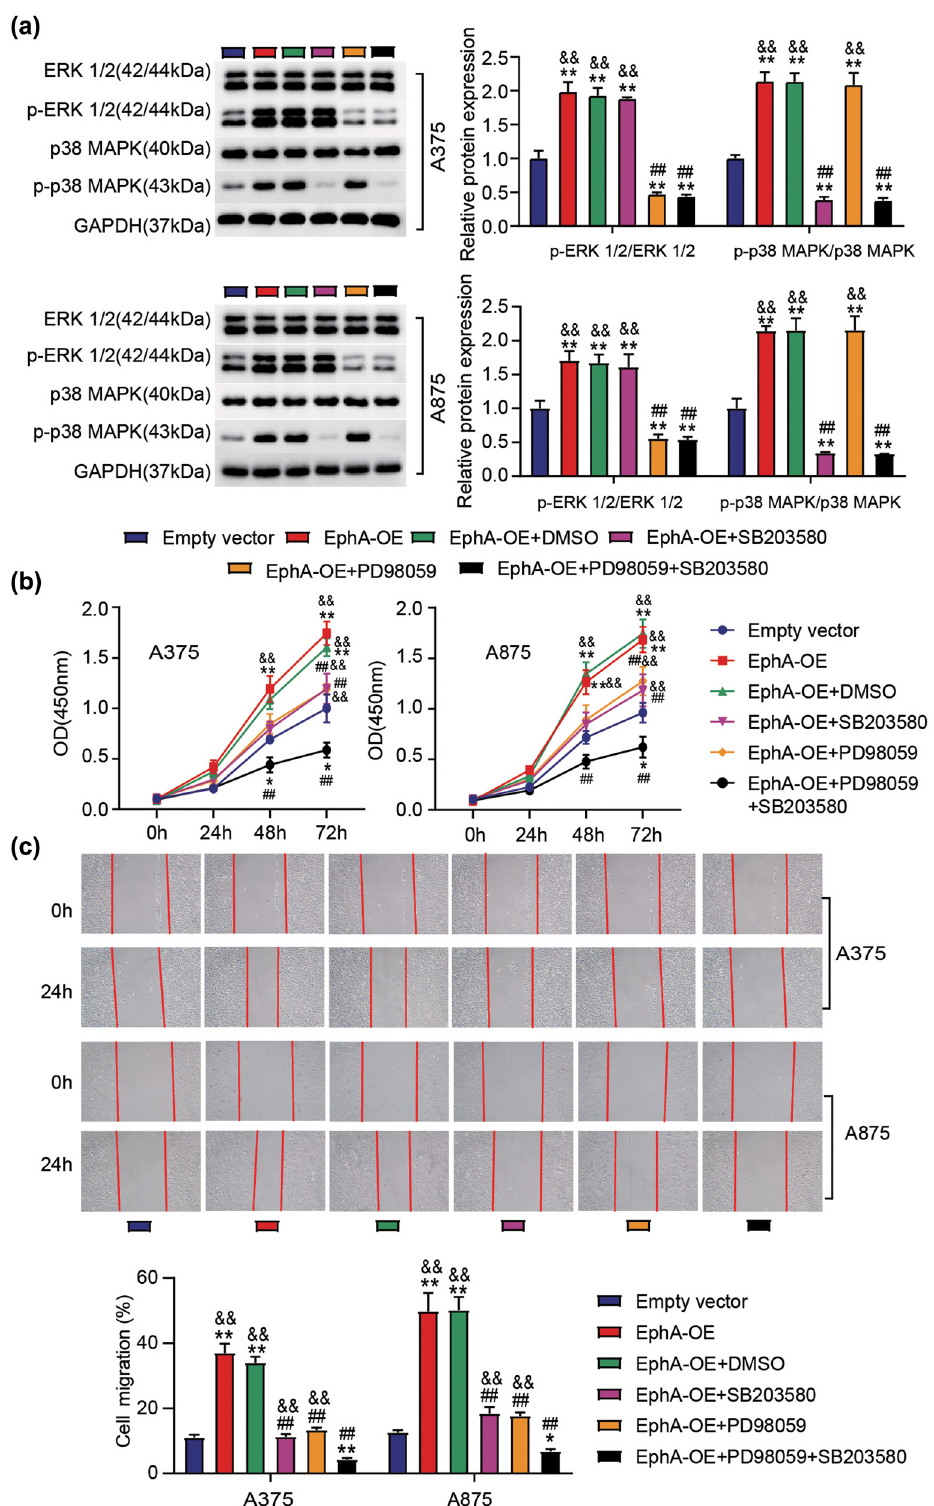
Figure 6: The inactivation of ERK1/2 and p38 MAPK signaling pathways ’ reverses the EphA3 - driven proliferation and migration in melanoma cells. A375 and A875 cells transfected with empty vectors or EphA3 overexpressing vectors ( EphA3 - OE ) were pretreated with D98059 ( ERK1/ 2 inhibitor ) or SB203580 ( p38 MAPK inhibitor ) . After 48 h transfection, ( a ) Western blot analysis of ERK1/2, p - ERK1/2, p38MAPK, and p - p38MAPK expressions in these above transfected cells. ( b ) Proliferation in these above treated cells was determined by CCK - 8 assay. ( c ) Migration in these above treated cells was assessed by scratch wound assays. P < 0.05, ** P < 0.01 vs empty vector; ## P < 0.01 vs EphA - OE; && P < 0.01 vs EphA - OE + PD98059 +